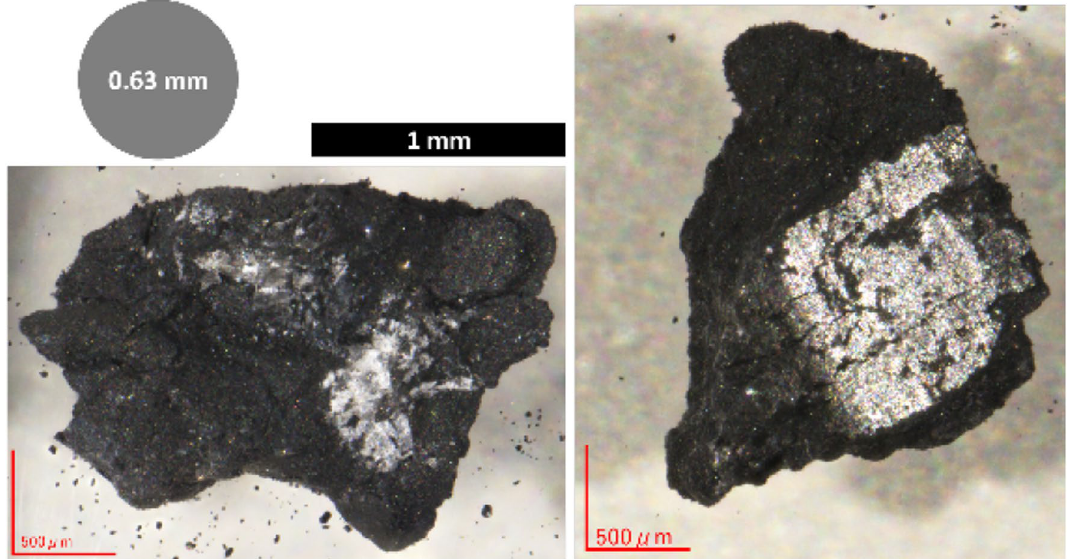
Fig. 5 Two examples of grains with brighter patches (left: C0041, right: A0038). The gray circle in the top left illustrates the average size of the inclusions identified by MasCam. The images are retrieved from the Hayabusa2, Ryugu Sample Curatorial Data Set (Astromaterials Science Research Group (ASRG)